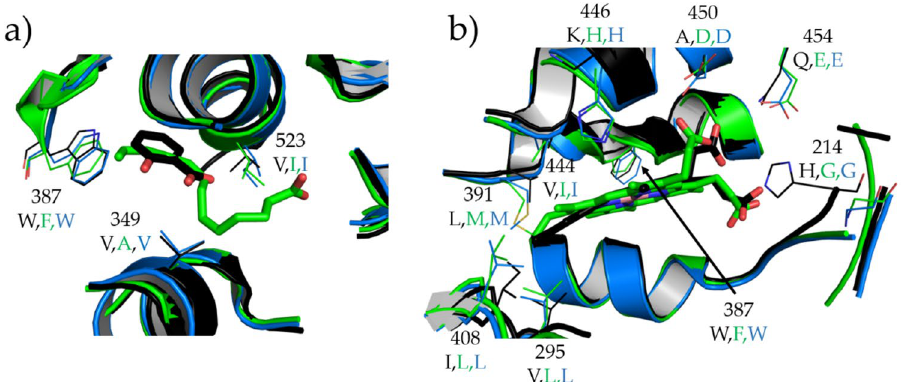
Figure 9. Comparison of the substrate ( a ) and heme ( b ) sites of COX proteins. h COX-1 (6Y3C) is in cyan color, o COX-1 (1U67) in green color, and h COX-2 (5F19) in black color. Residues not conserved among the proteins are drawn in line representation, whereas ligand molecules related to o COX-1 and h COX-2 are drawn in stick